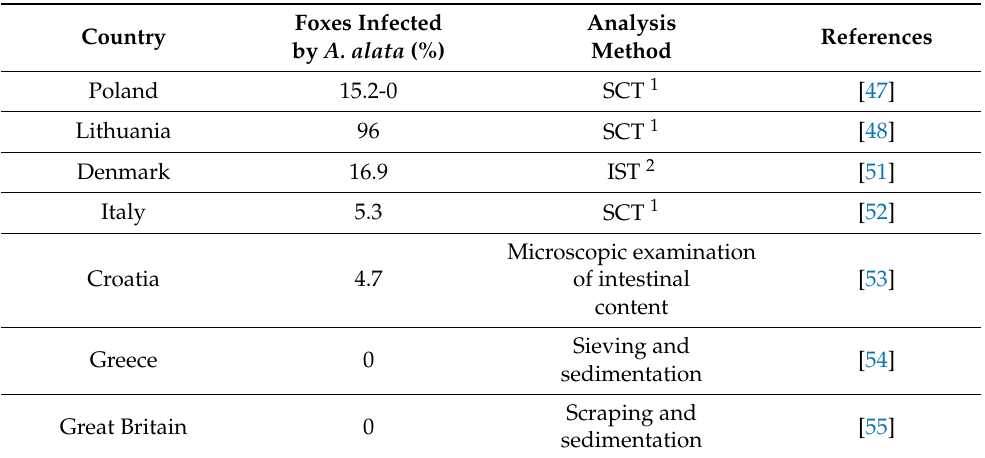
Table 1. Prevalence of A. alata in red foxes in